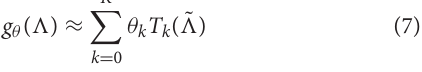
The graph convolutional neural network is the network using convolution operations on the graph. Given a graph G ( V , E ), = V where V refers to the vertex set with n nodes, and E is a | | = set of edges between nodes. Data on vertex V can be represented R n f , where n represents the by a set of feature matrix X × ∈ number of nodes and f represents the feature dimension. The edge set E can be represented by a set of weighted adjacency R n n describing the connections between matrices A × ∈